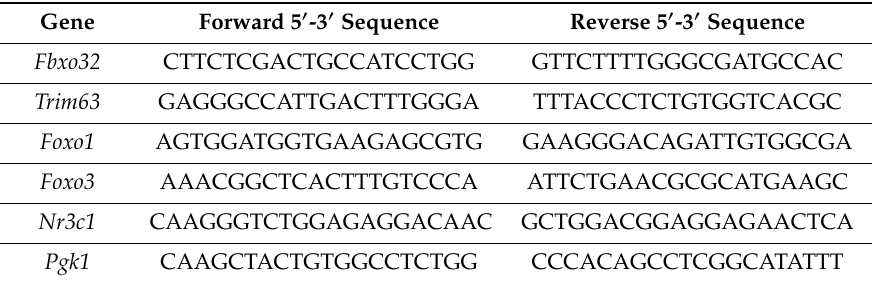
Table 2. Primers used in this manuscript. Key atrophy transcripts Fbxo32 and Trim63 (encoding Atrogin-1 and MuRF1, respectively) and their upstream regulators Foxo1 and Foxo3. Nr3c1 (encodes the glucocorticoid receptor) and Pgk1 was used as a control